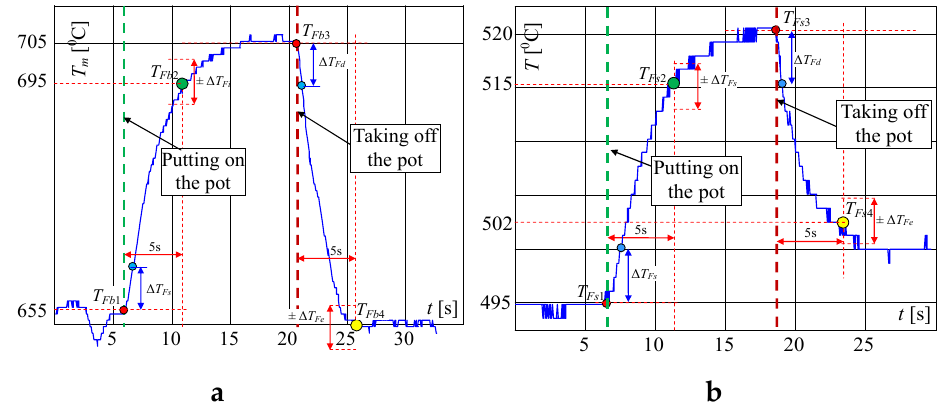
Figure 8. Extended characteristics measured by a factory mounted thermocouple if putting the pot on and removing it from the burner, when the flame is: ( a ) big; ( b ) small; explanation: red circle—start points of temperature changes: T Fb 1 , T Fb 3 and T Fs 1 , T Fs 3 ; blue circle—points for recognition that the temperature changes significantly within 1s; green circle – recognition that the pot is placed on the burner T Fb 2 , T Fs2 (temperatures after 5 s); yellow circle—recognition that the pot is taken from the burner T Fb 4 and T Fs 4.